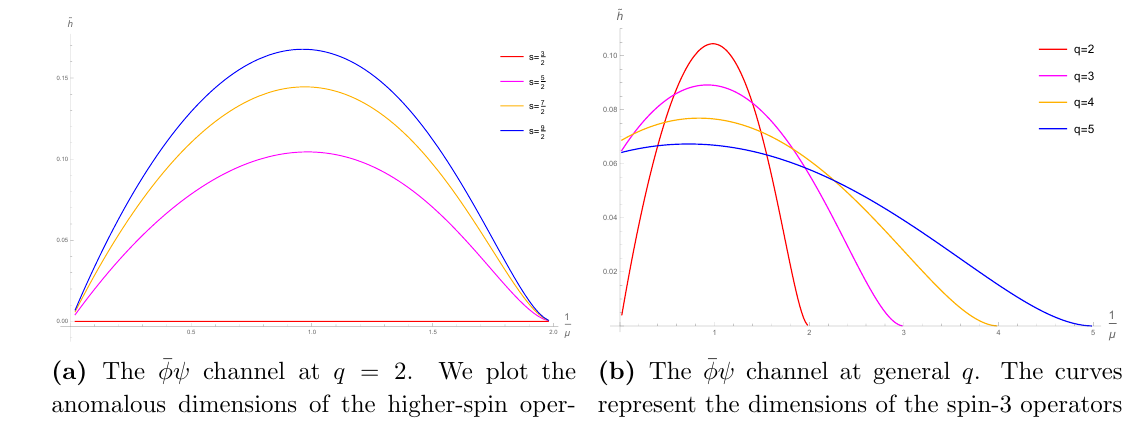
(a) The (cid:22) (cid:30) channel at q = 2. We plot the (b) The (cid:22) (cid:30) channel at general q . The curves anomalous dimensions of the higher-spin oper- represent the dimensions of the spin-3 operators ators with half-integer spin. in models with di(cid:11)erent q . Figure 14. The lowest dimensions of the fermionic operators in the h (cid:30) i (cid:22) i j (cid:22) (cid:30) j i and h (cid:30) i (cid:22) i G j (cid:22) (cid:21) j i four point function. The plots illustrate how does the dimension change as a function of (cid:22)